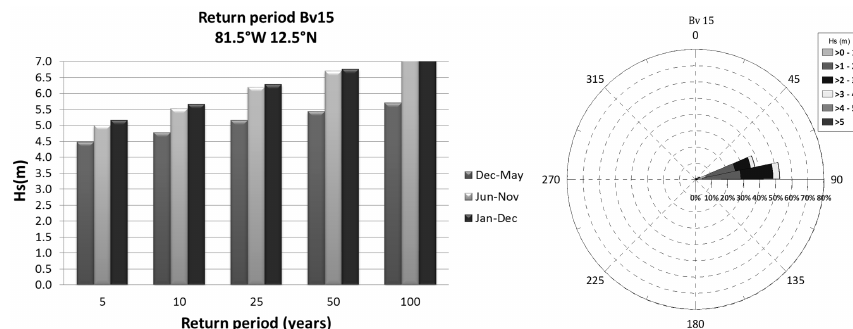
Figure 9. Return periods for H s of virtual buoys BV15 (zone